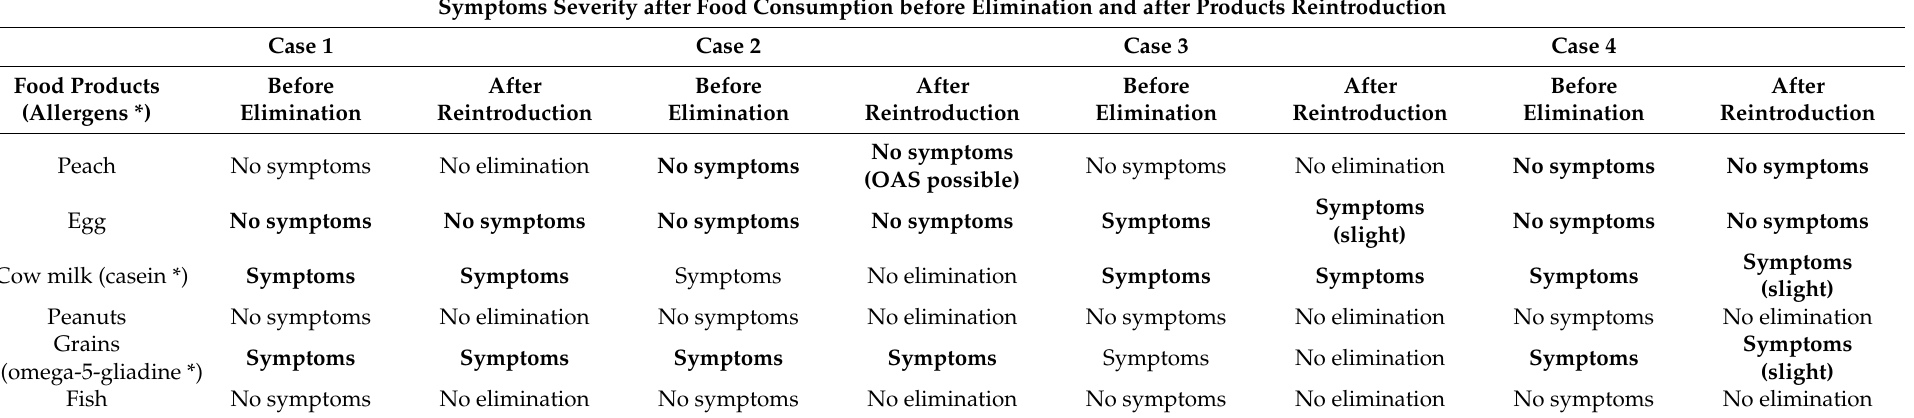
Table 2. Assessment of symptoms severity after food consumption before elimination and after reintroduction the products. Products in bold were eliminated after IgG4 concentration measurement (value above 0.1 mgA / L) and after symptoms assessment. OAS (Oral Allergy